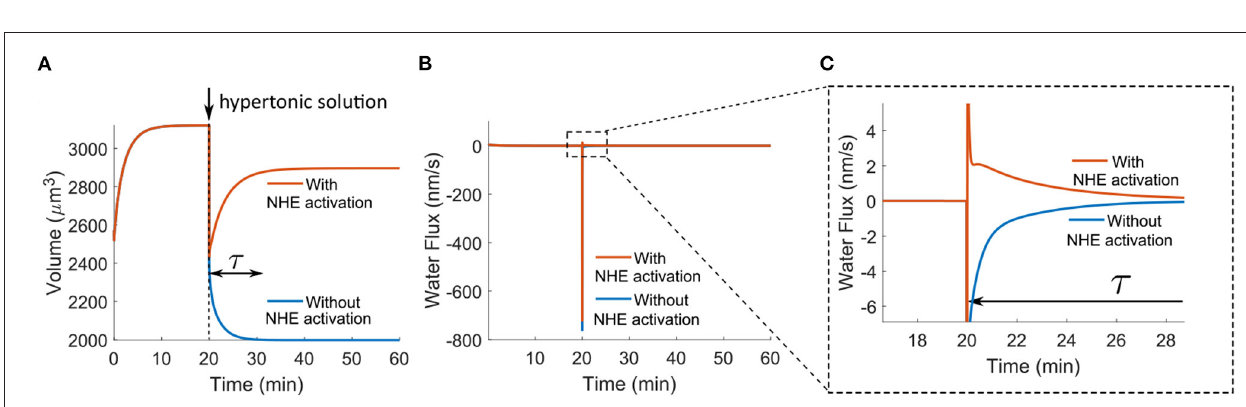
FIGURE 5 | Model predictions of the cell response in the hypertonic solution applied at t 0 = 20 min. The hypertonic solution is applied by adding 50 mM NaCl to the isotonic solution. The permeability coefficient of NBC has been increased by 20 times as compared to the value used in Figures 2 , 3 . (A) Time-dependent response of the cell volume. NHE activation is achieved by increasing the permeability coefficient of NHE by three orders of magnitude at t 0 = 20 min. (B) Predicted water flux over time. (C) Zoomed-in profile in